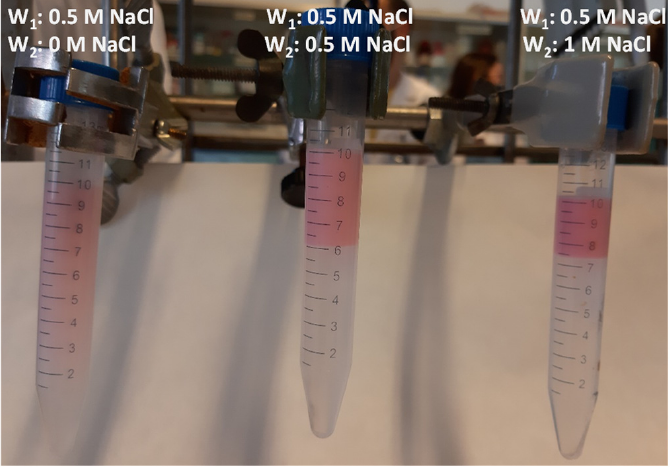
Figure 6. Visual inspection of the osmotic pressure balance acting on the swelling and deswelling in double emulsions.